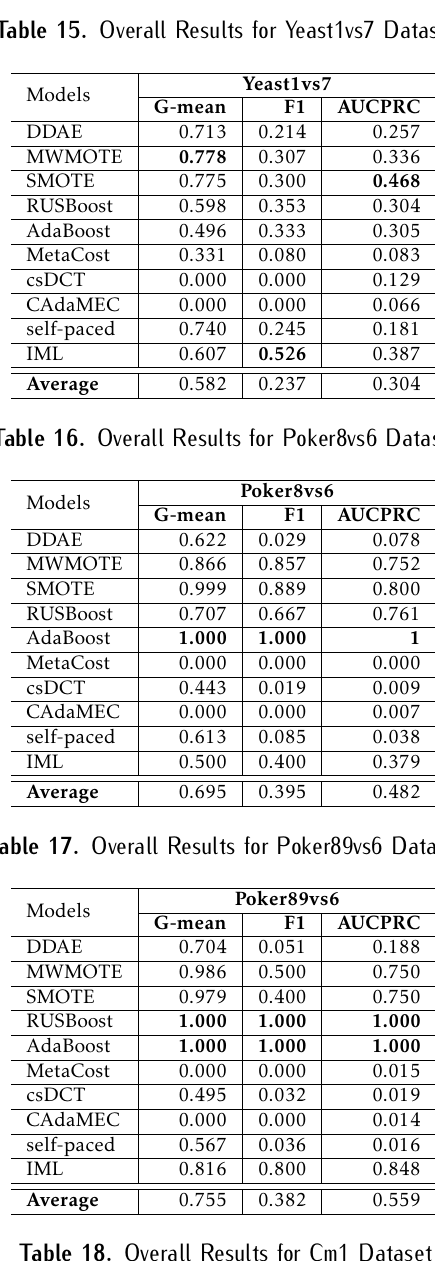
Table 14. Overall Results for PID Dataset Models